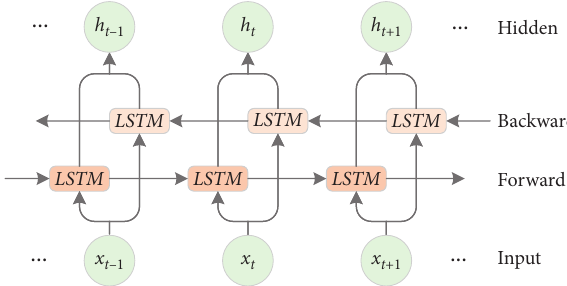
Figure 5: The structure of BiLSTM network.